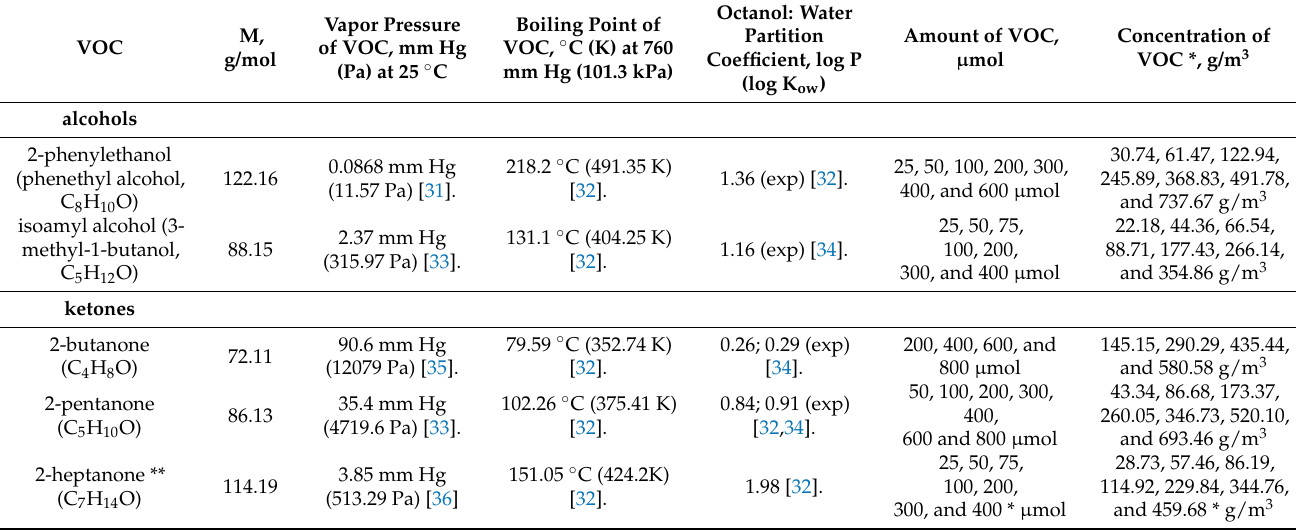
Table 1. Physical and chemical properties of